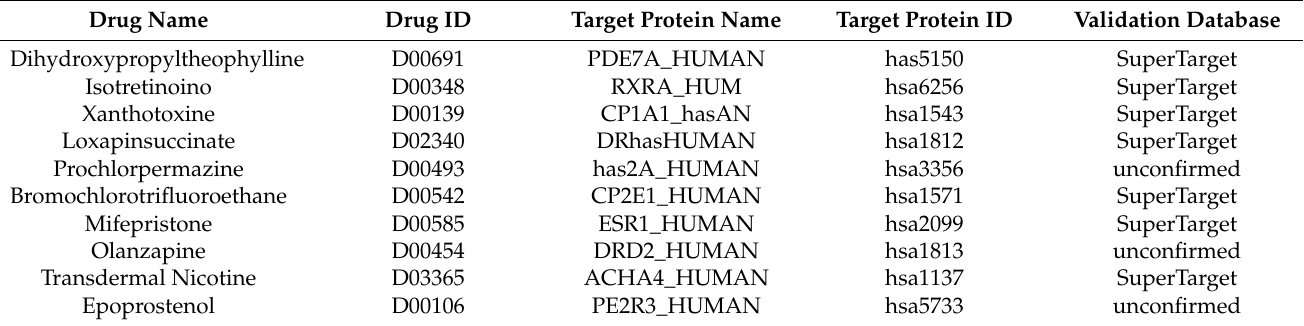
Table 8. Top 10 DTI pairs predicted by RoFDT on the SuperTarget